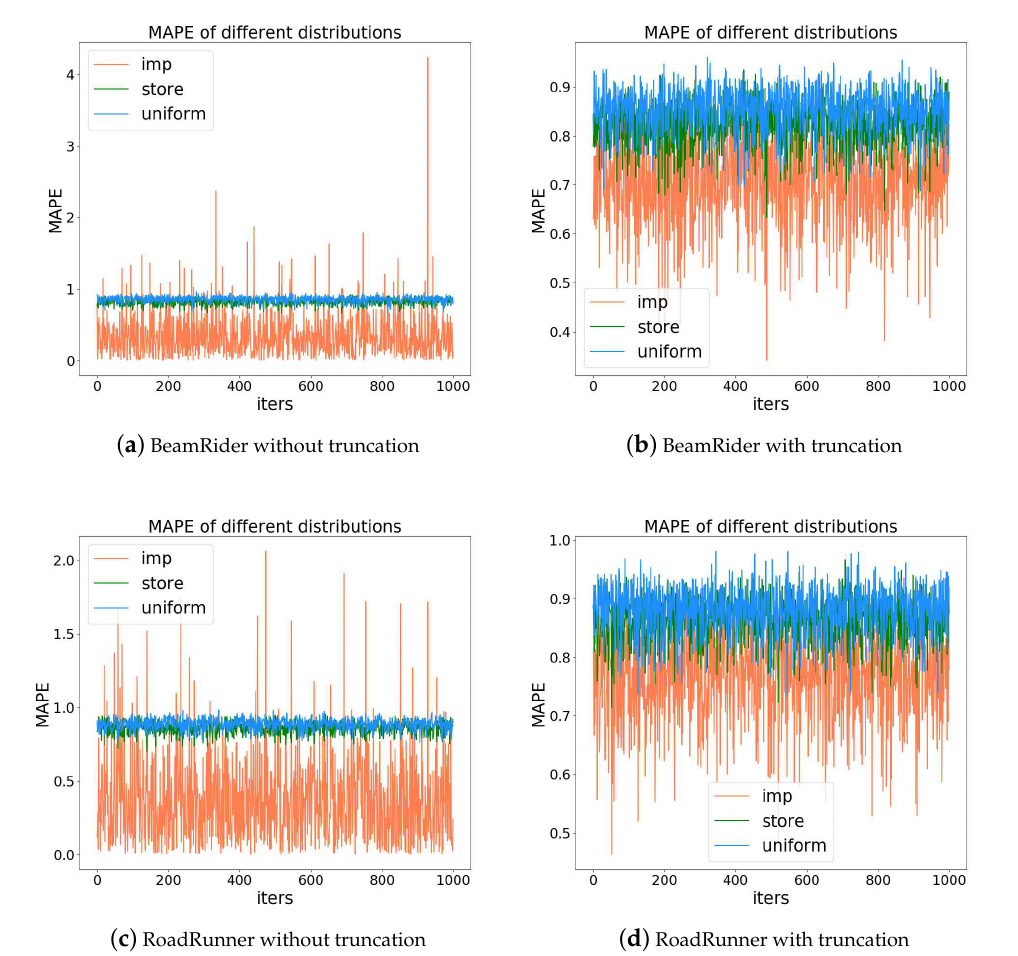
Figure 7. The Mean Absolute Percentage Error (MAPE) of uniform, stored, and importance sampling. Each experiment runs 1000 times. The red, green, and blue curves represent imp, store, and uniform,